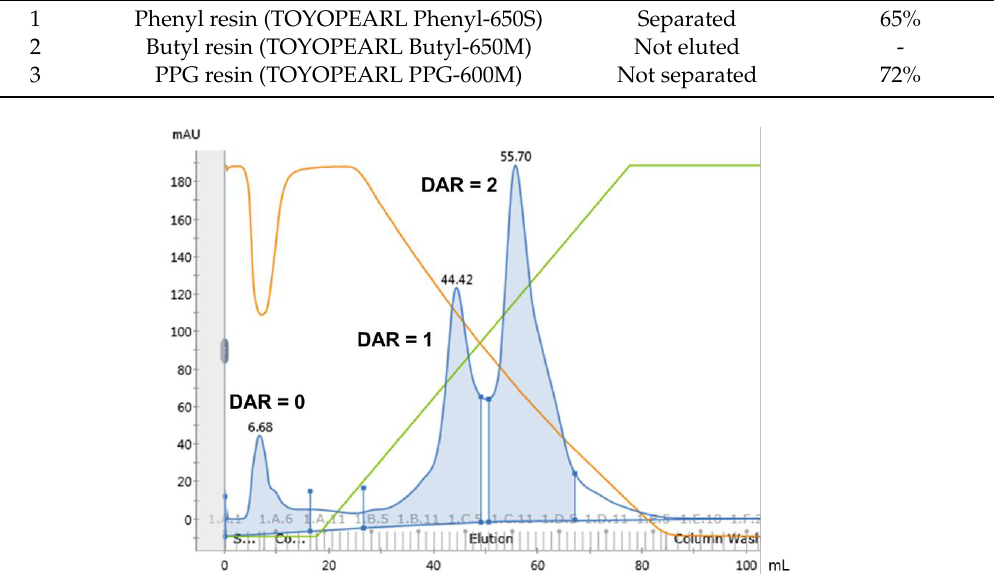
Figure 4. Chromatogram results of a Toyopearl Phenyl-650S column used for separation of different drug antibody ratio (DAR) species of unpurified trastuzumab-AJICAP ™ -MMAE (4). Blue line and